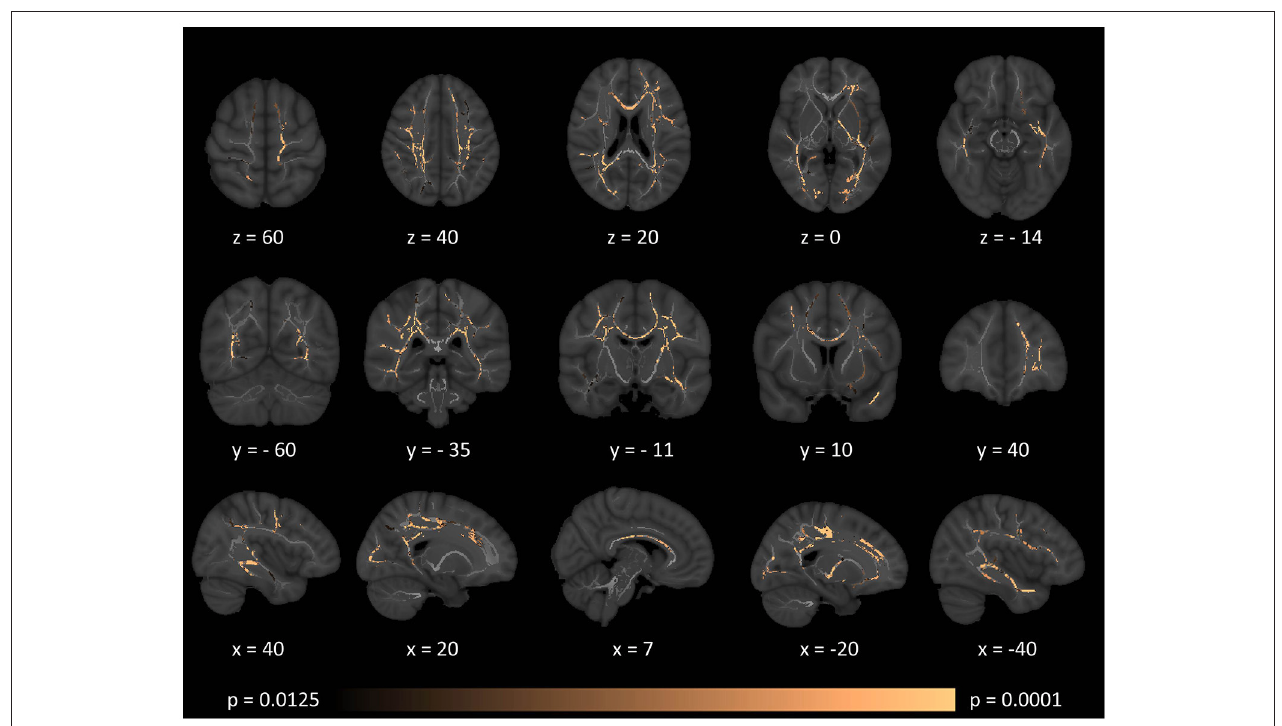
FIGURE 5 | Patterns of increased radial diffusivity (RD) in multiple sclerosis patients with gave-evoked nystagmus compared to healthy controls at p < 0.0125 FWE adjusted for age and gender following tract-based spatial statistics. Representative axial, coronal, and sagittal views are presented with corresponding MNI coordinates.